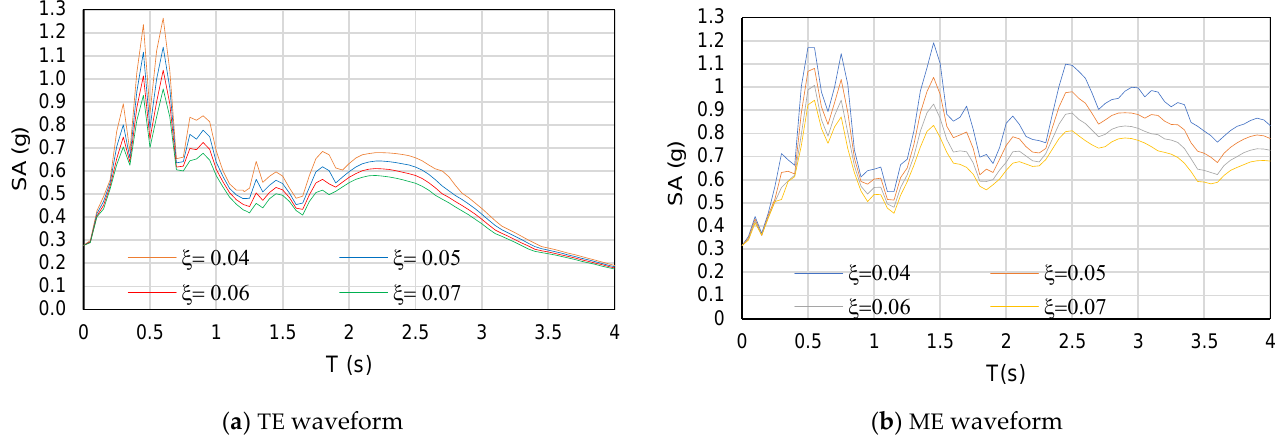
Figure 15. FEA: Ground surface SAs with various damping coefficients. The FEA results for Scenario 1 using the TE and ME waveforms are described in Table 4. The maximum PSW acceleration was obtained directly from the FEA results. The PSW’s natural period was derived from the predominant frequency of the Fourier spectra. The PSW maximum acceleration and Fourier spectra were generated for the top right (seaward side) end of the PSW deck. The PSW damping coefficients shown in Table 4 were determined so that the deck’s FEA maximum accelerations matched the SAs generated by the FEA ground surface motions, as shown in Figure